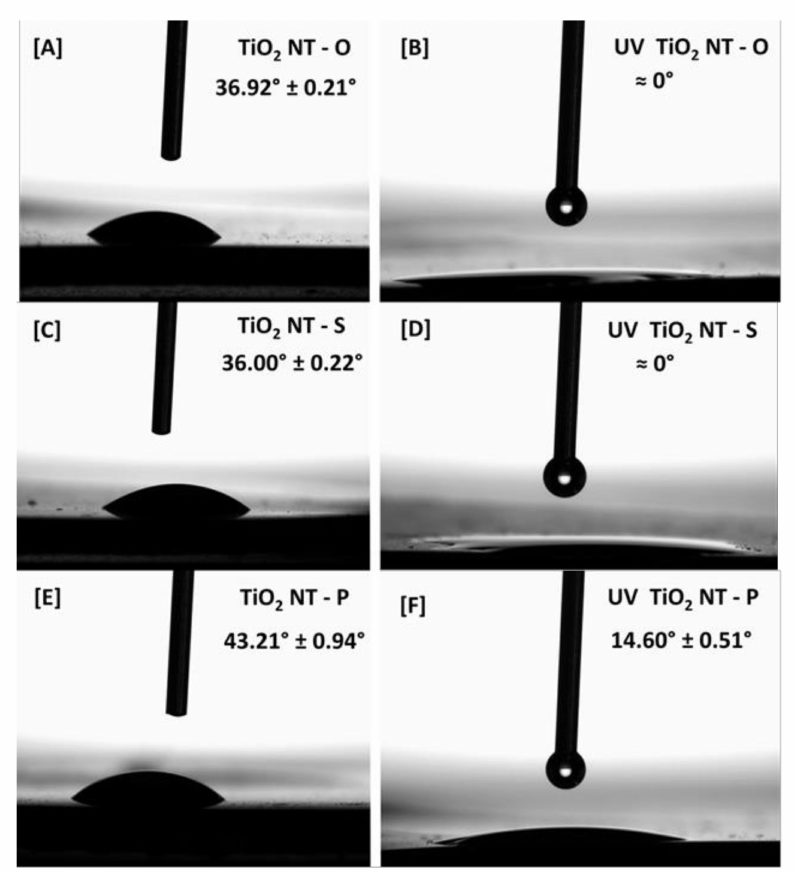
Figure 3. Optical contact angles of the nanotube arrays. ( A ) TiO 2 NT-O without irradiation; ( B ) TiO 2 NT-O with UV irradiation; ( C ) TiO 2 NT-S without irradiation; ( D ) TiO 2 NT-S with irradiation; ( E ) TiO 2 NT-P without irradiation; ( F ) TiO 2 NT-P with UV